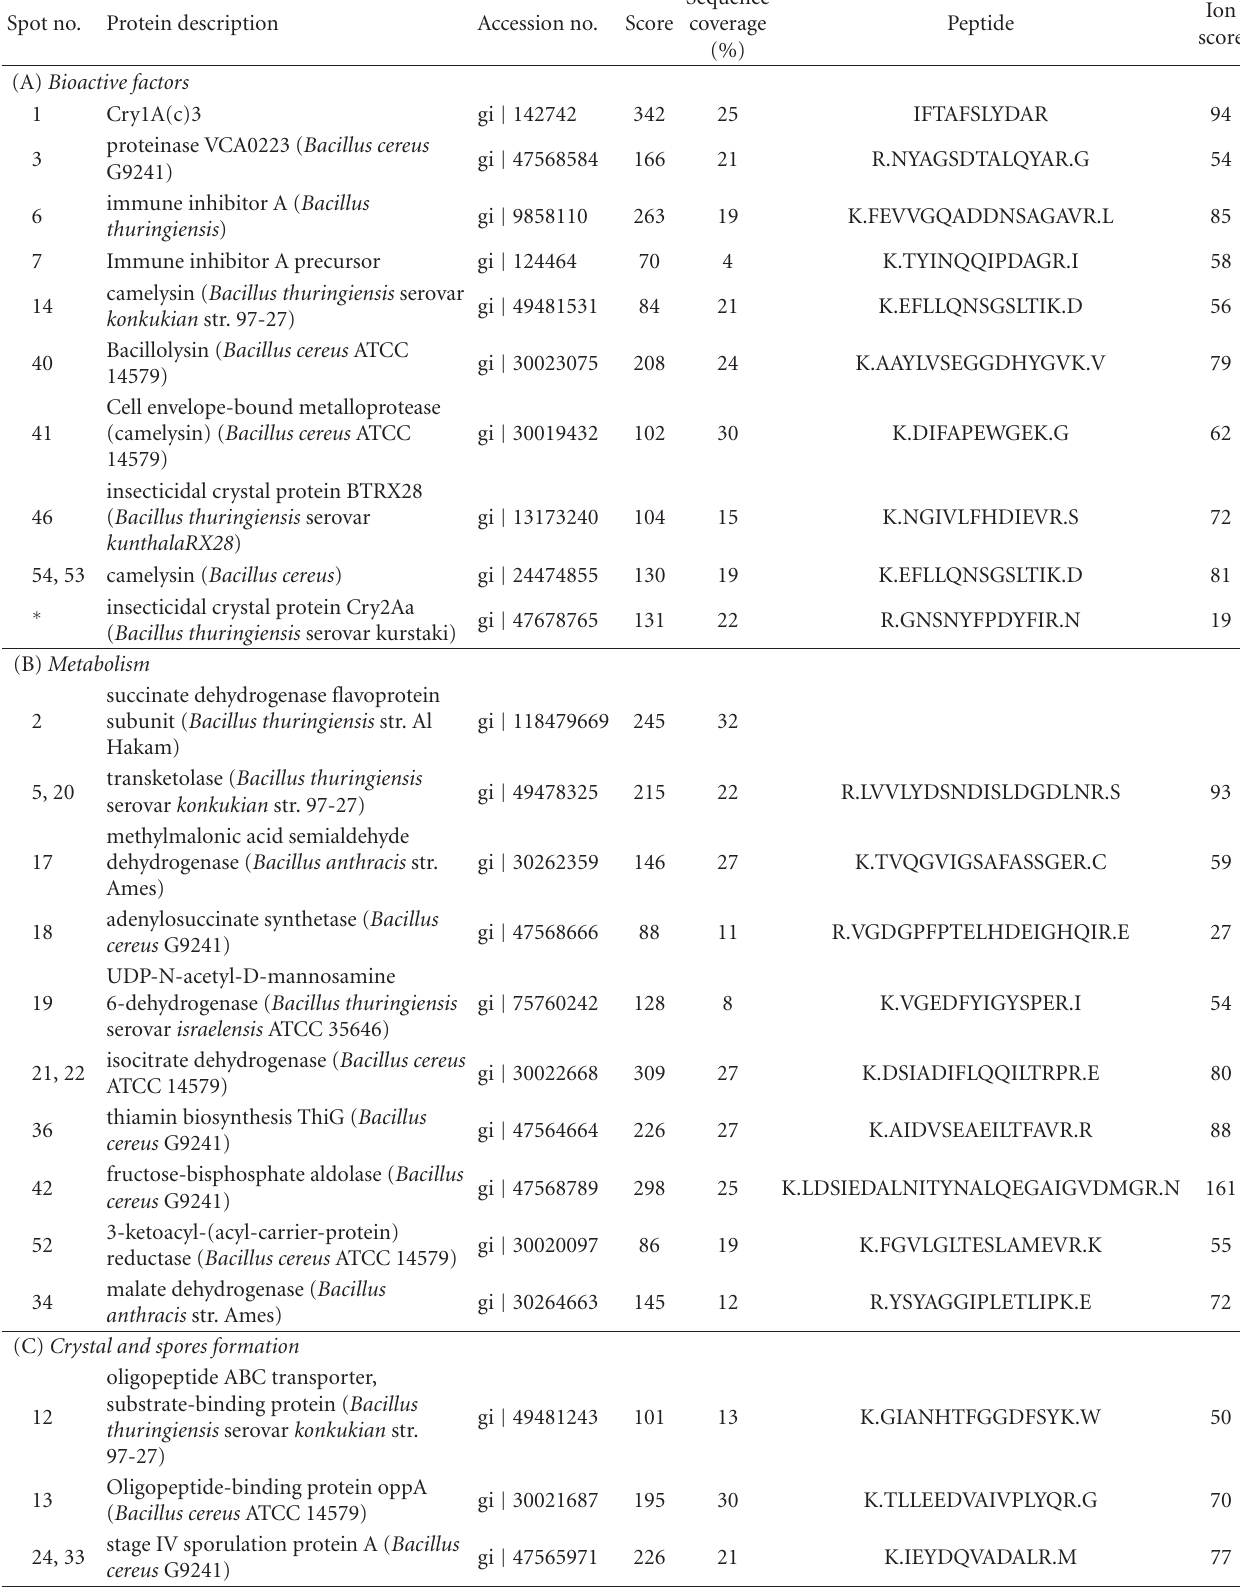
Table 2: Proteins identified by MALDI-TOF/TOF